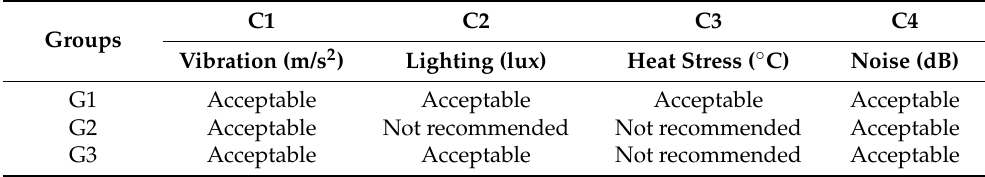
Table 15. Quality level by criteria for each